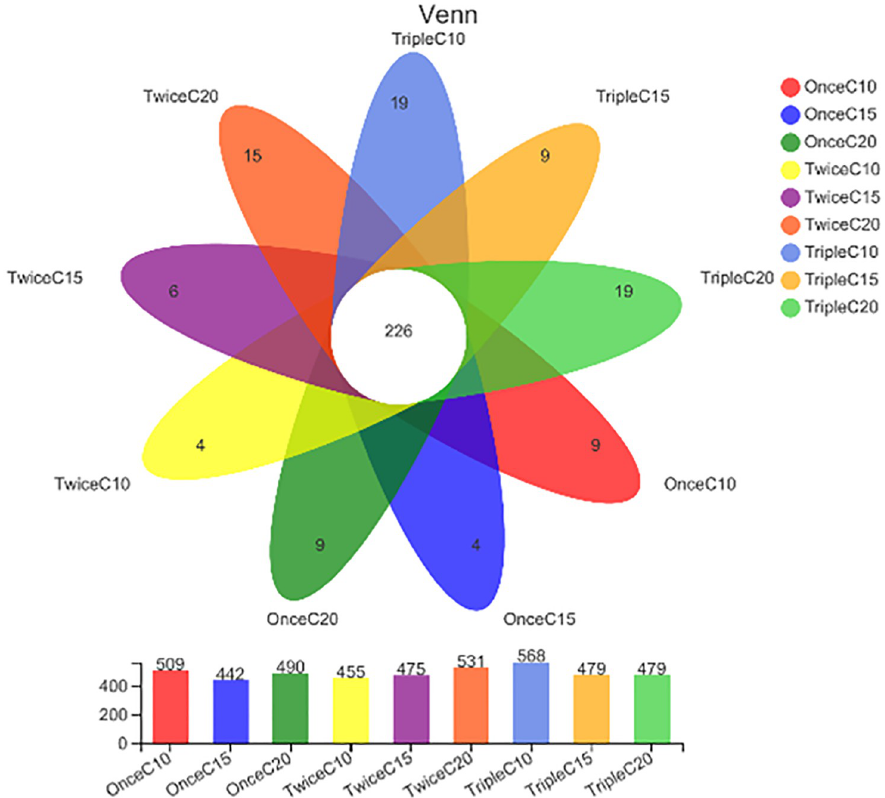
Fig 4. Venn diagram showing unique and shared operational taxonomic units (OTUs) of intestinal bacteria of Litopenaeus vannamei reared in biofloc under different frequent addition times of carbon source (starch) (once, twice, triple) on daily basis and C/N ratios (10, 15, 20). T1; once C/N 10, T2; once C/N 15, T3; once C/N 20, T4; twice C/N 10, T5; twice C/N 15, T6; twice C/N 20, T7; triple C/N 10, T8; triple C/N 15, T9; triple C/N 20.